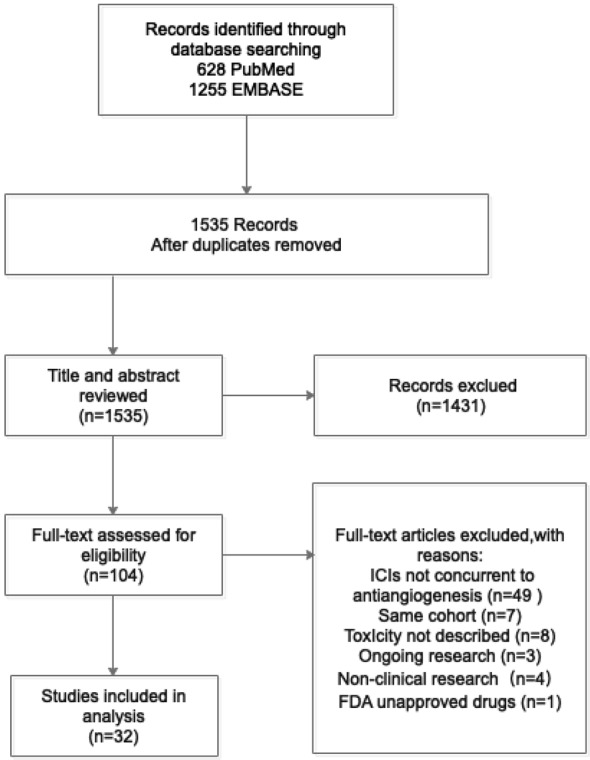
Search flow diagram.